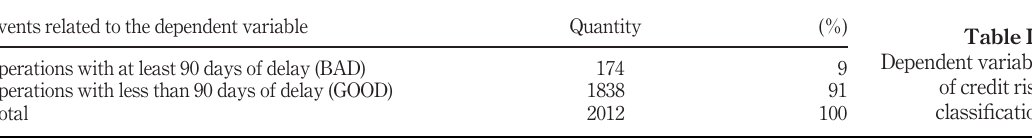
Table II. Dependent